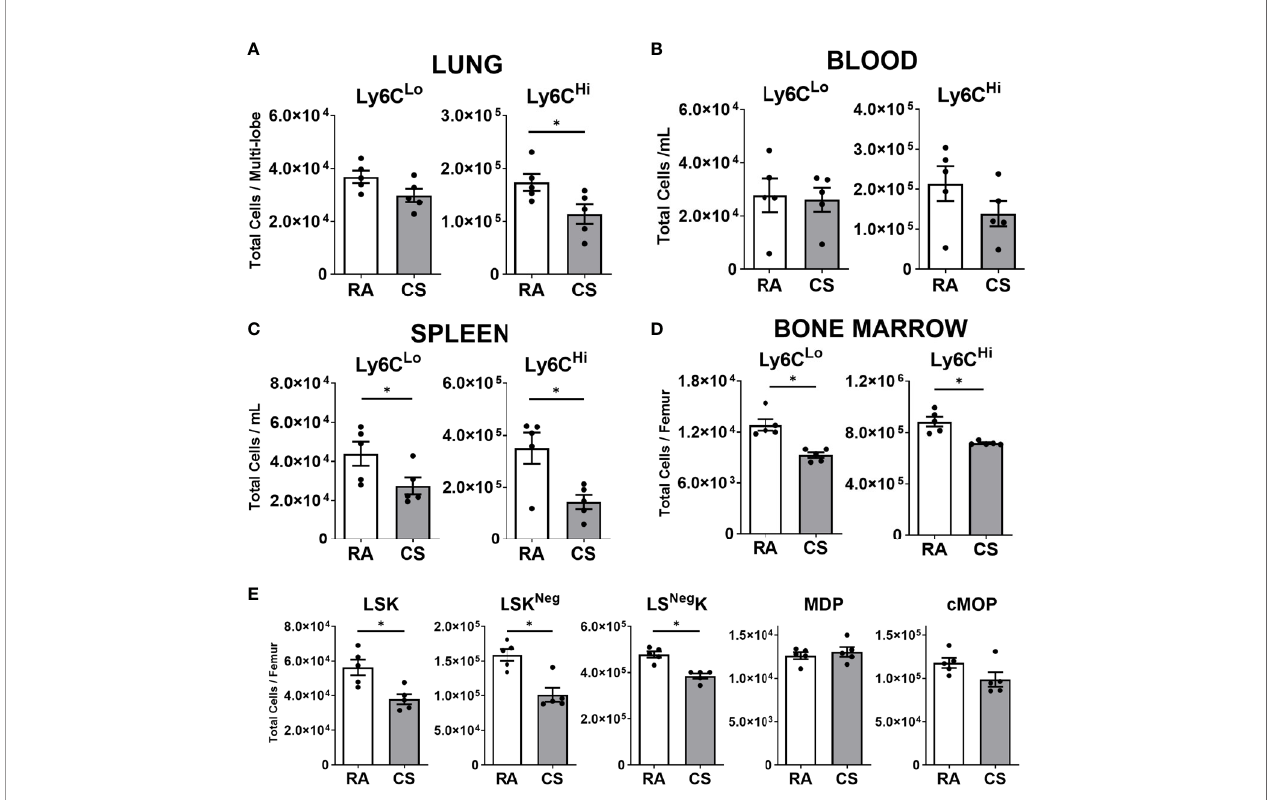
FIGURE 3 | Macrophage progenitor cells are transiently decreased at 12-weeks of cigarette smoke exposure. Female C57BL/6 mice were RA or CS-exposed for 12-weeks. Data show total numbers of Ly6C Lo and Ly6C Hi monocyte populations in (A) lungs, (B) blood, (C) spleen, and (D) bone marrow. Shown in (E) total numbers of macrophage progenitor cells in the bone marrow (lineage-negative Sca1 c-Kit (LSK), monocyte-macrophage dendritic cell progenitor (MDP), common monocyte progenitor (cMoP)). Data show mean ± SEM, n = 5. Unpaired t test with Welch ’ s correction. RA, room air; CS, cigarette smoke. *p <